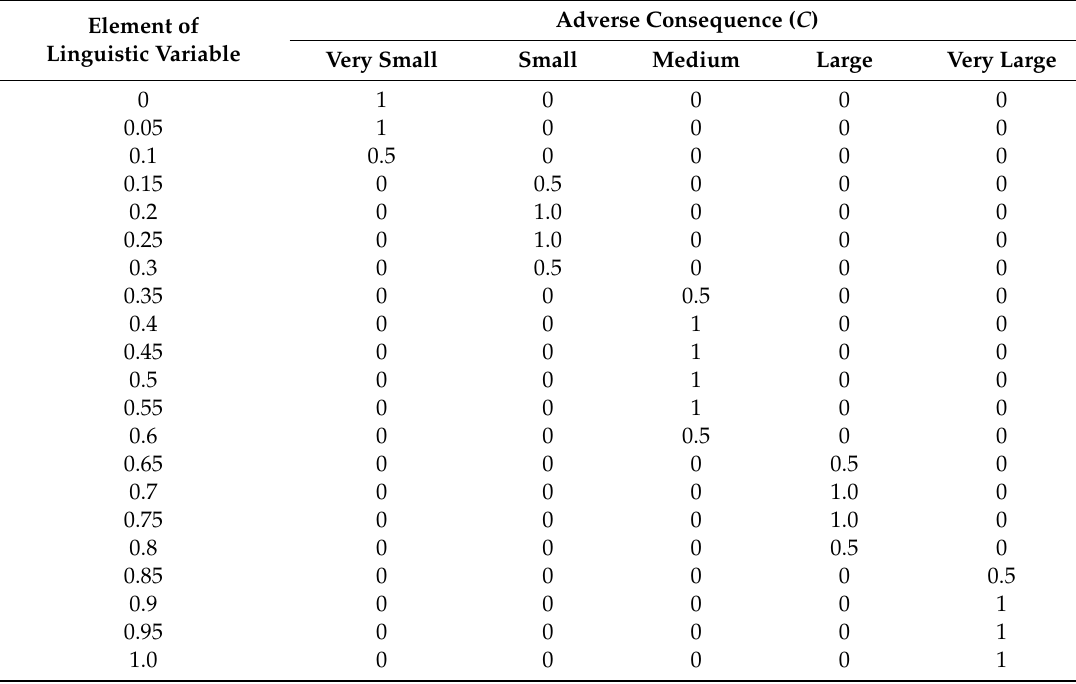
Figure 9. Marginal Beta distribution of cost-risk impact after changing the membership function of ( F ). Table 11. New membership function for adverse consequence ( C